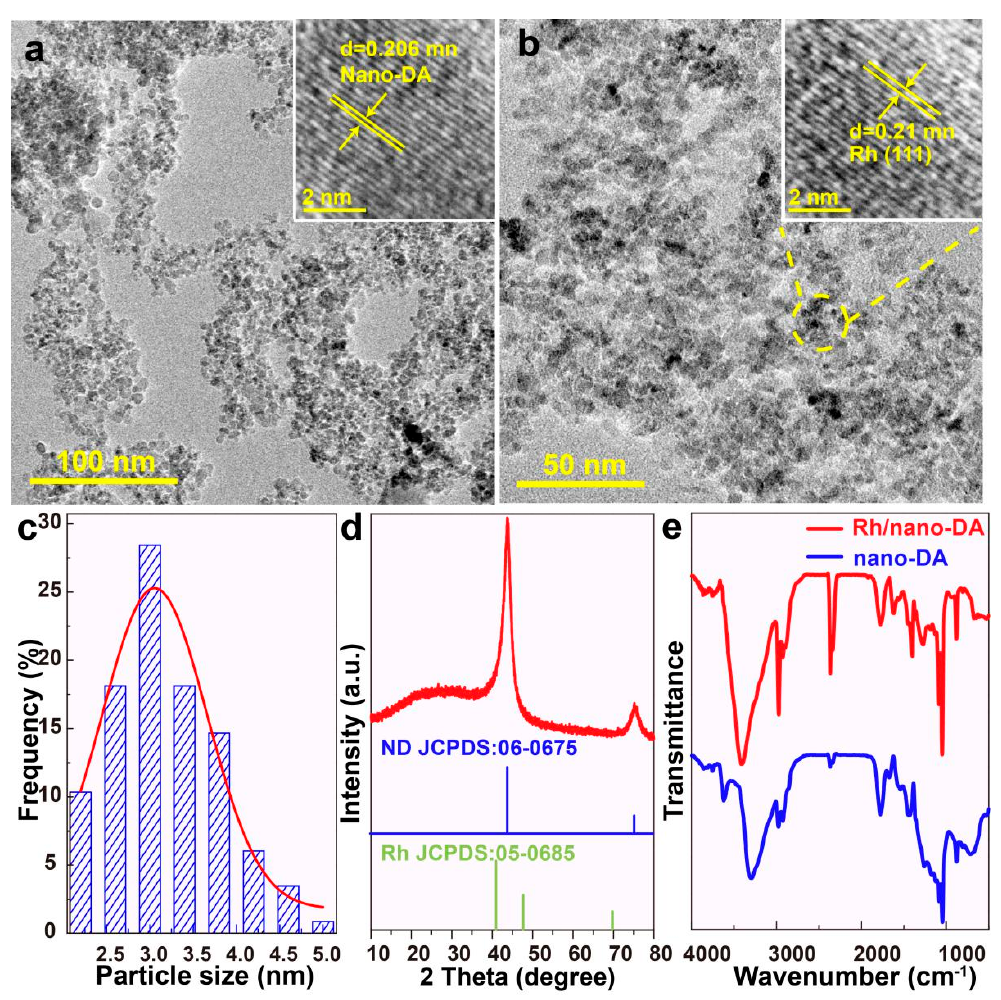
Figure 1. ( a , b ) TEM images of Rh / nano-DA (Inset: HRTEM images). ( c ) Particle size distribution of Rh / nano-DA. ( d ) XRD pattern of Rh / nano-DA. ( e ) FT-IR analysis of nano-DA and Rh / nano-DA.